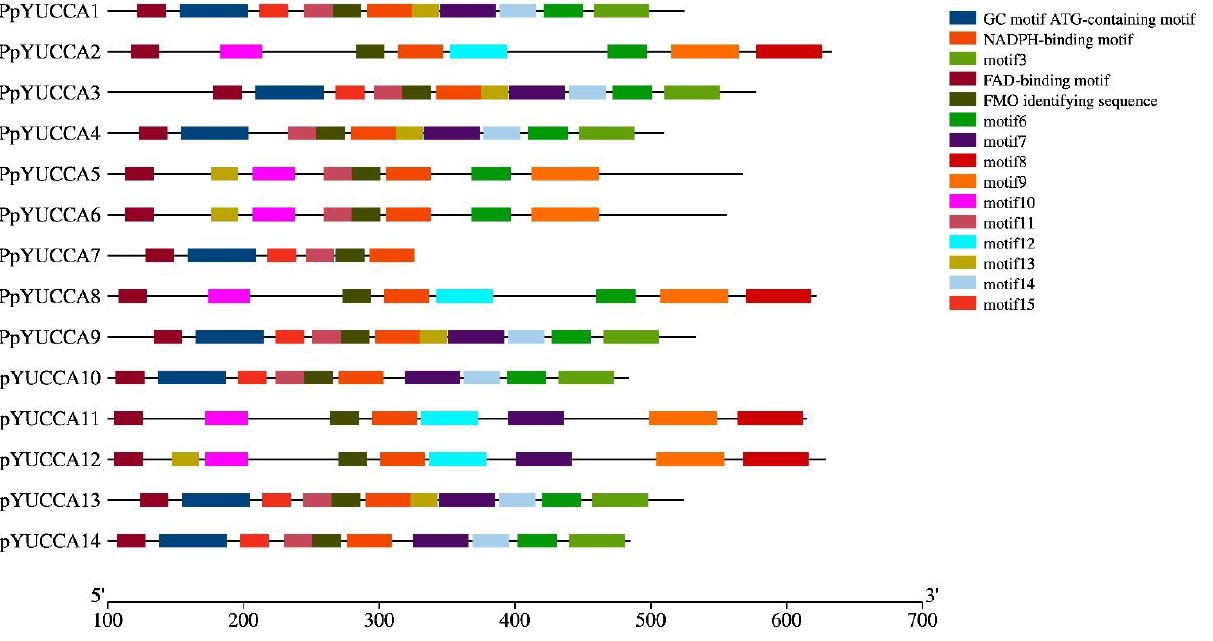
Figure 3. YUCCA gene family motifs in Prunus persica var. pendula. The various conserved motifs are labeled with colored boxes.